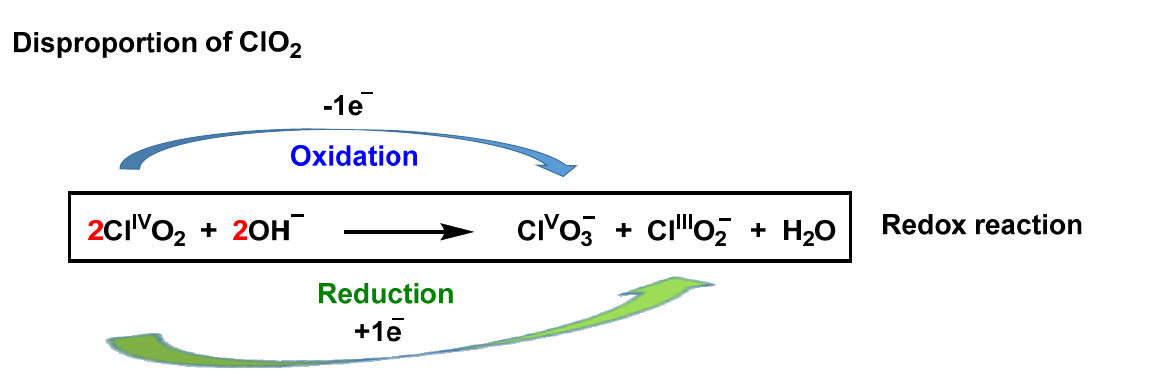
Figure 7. ClO 2 as an oxidizing and reducing agent.